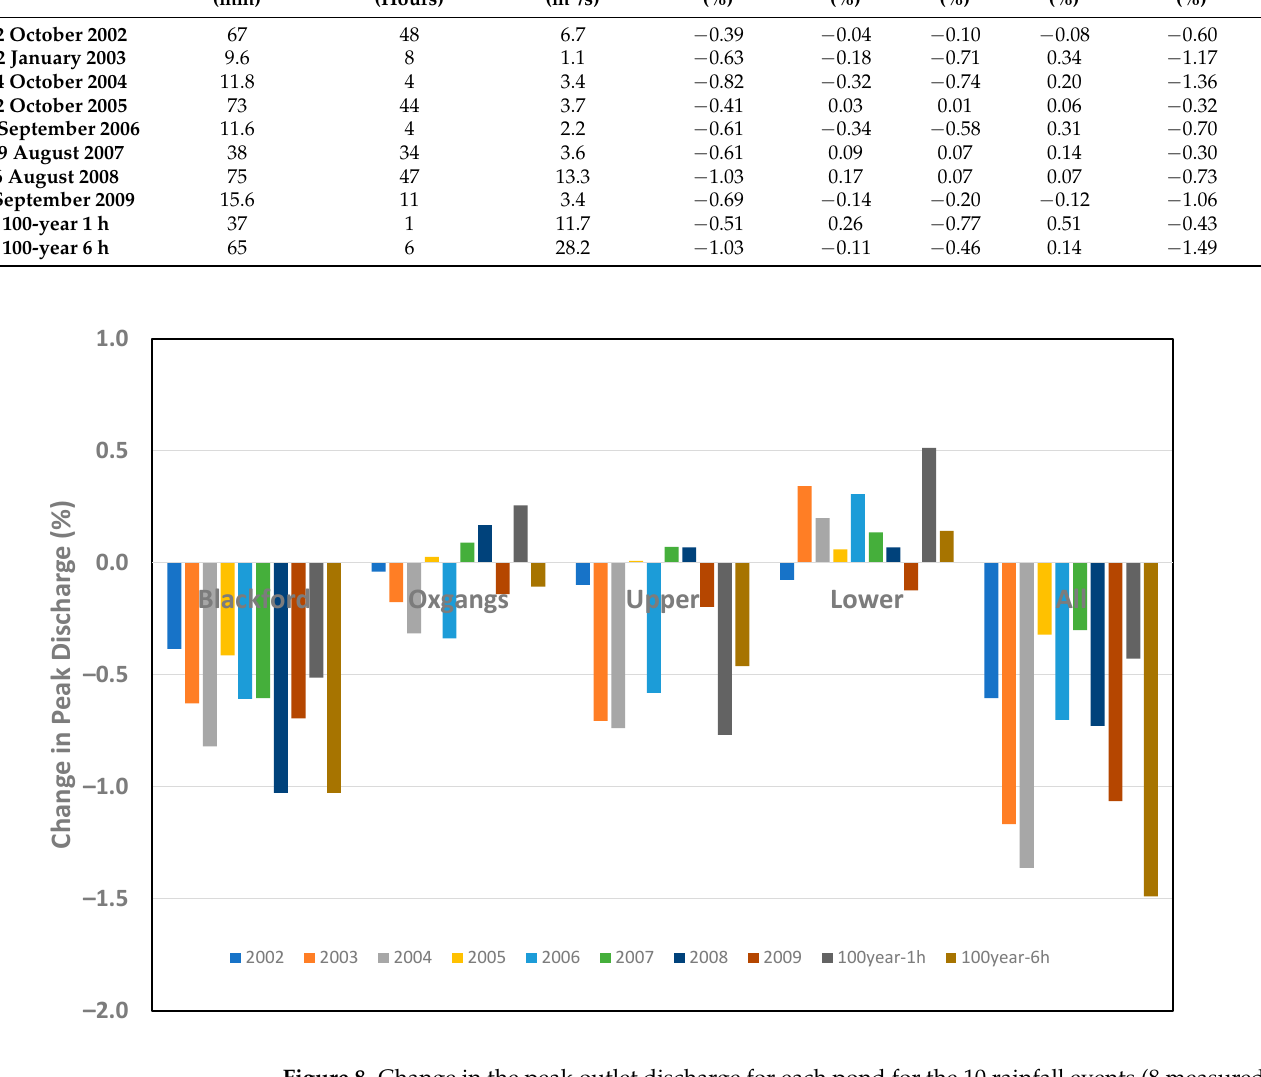
Figure 8. Change in the peak outlet discharge for each pond for the 10 rainfall events (8 measured events that produce annual maximum discharges and 2 design events). Additionally shown are the synergistic results for the catchment outlet due to incorporating all the ponds into the model. These results are for the standard storage.